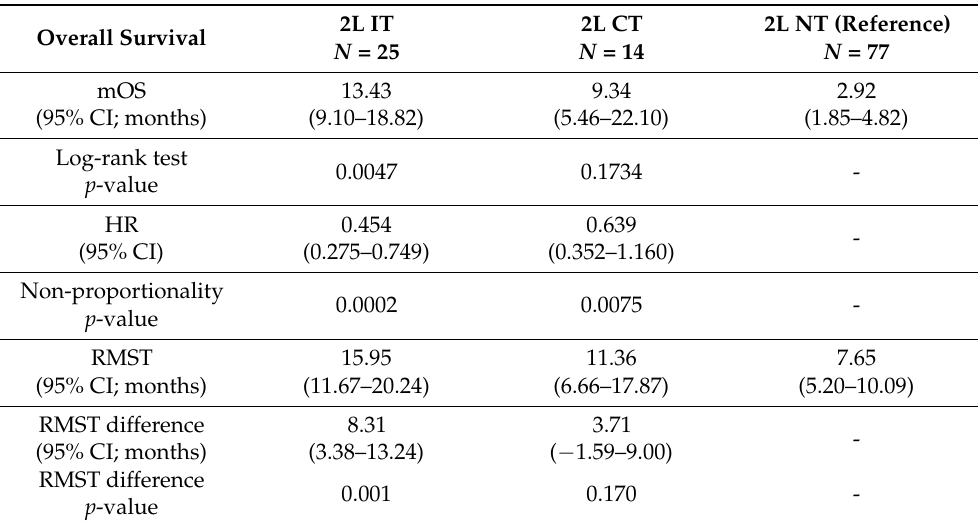
Table A5. Median overall survival from termination of first-line therapy for second-line palliative systemic treatments versus no treatment.